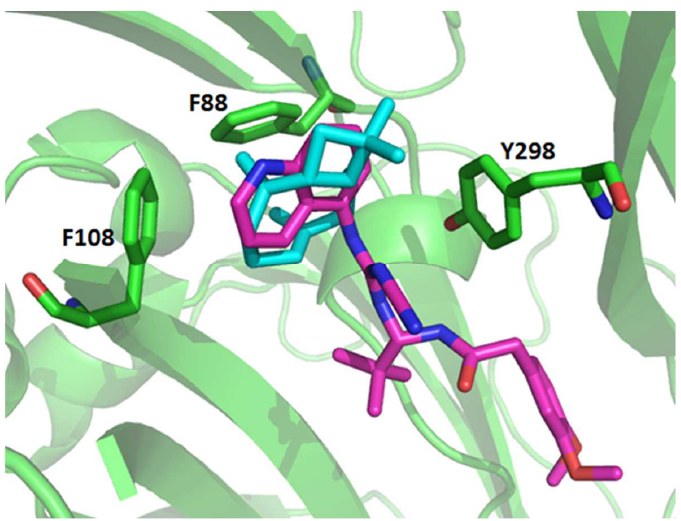
Figure 9. Representation of the possible conformations of the β-caryophyllene docked into the P2X7R. The P2X7 is represented in cartoon and colored in green. The residues from the P2X7R that present the most interaction with the ligand β-caryophyllene are shown in the stick. The β-caryophyllene is depicted in cyan. The ligand A740003 derived from the crystallographic structure (PDB: 5U1U) is depicted in pink.